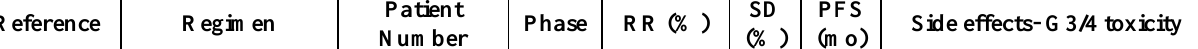
Table 4. Anti-EGFR Monoclonal Antibodies and low-molecular weight Tyrosine Kinase Inhibitors (TKIs) in patients with ovarian